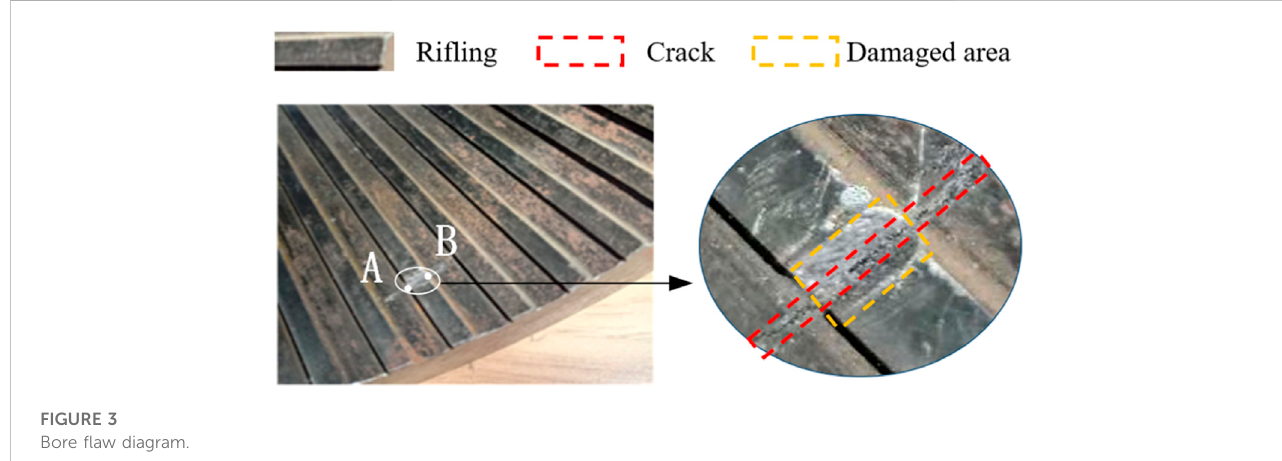
FIGURE 3 Bore fl aw